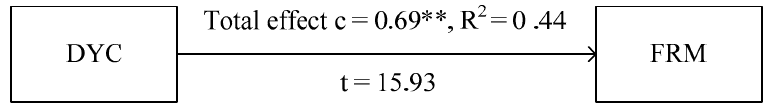
Figure 2. Influence of independent variable (DYC) on dependent variable (FRM). Note: ∗∗ p < 0.001.